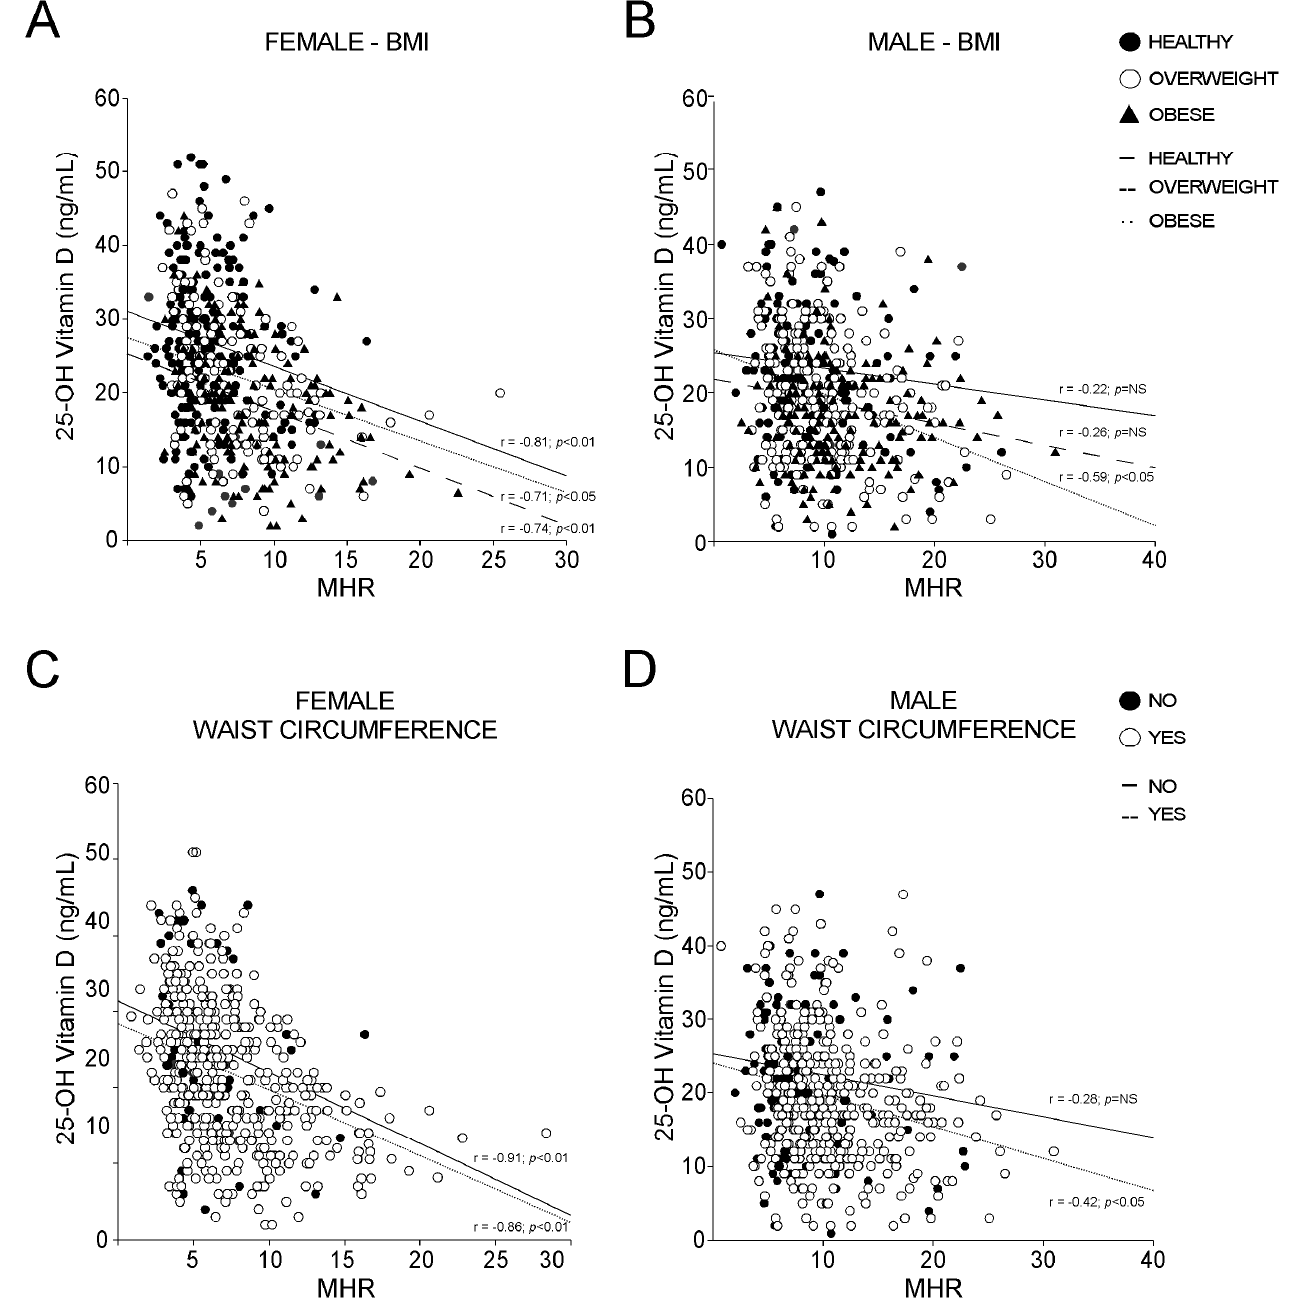
Figure 7. Correlation between 25-OH vitamin D and Monocyte-to-HDL ratio according to BMI definition and waist circumference criterion for MetS. ( A , B ) Correlation analysis of 25-OH vitamin D and MHR in female and male subjects, divided according to BMI levels in healthy, overweight, and obese. ( C , D ) Correlation analysis of OH-25 vitamin D and MHR in female and male subjects, classified by absence (NO) and presence (YES) of positive waist circumference criterion for